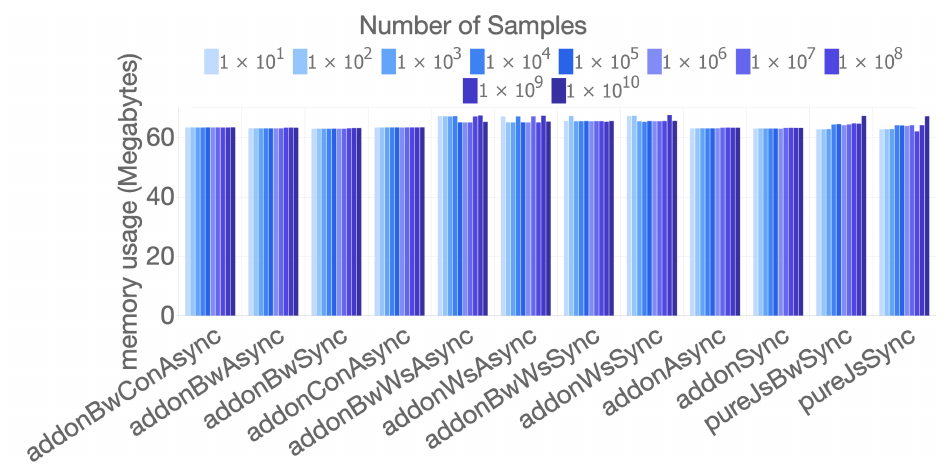
Figure 6. Average peak memory allocation in